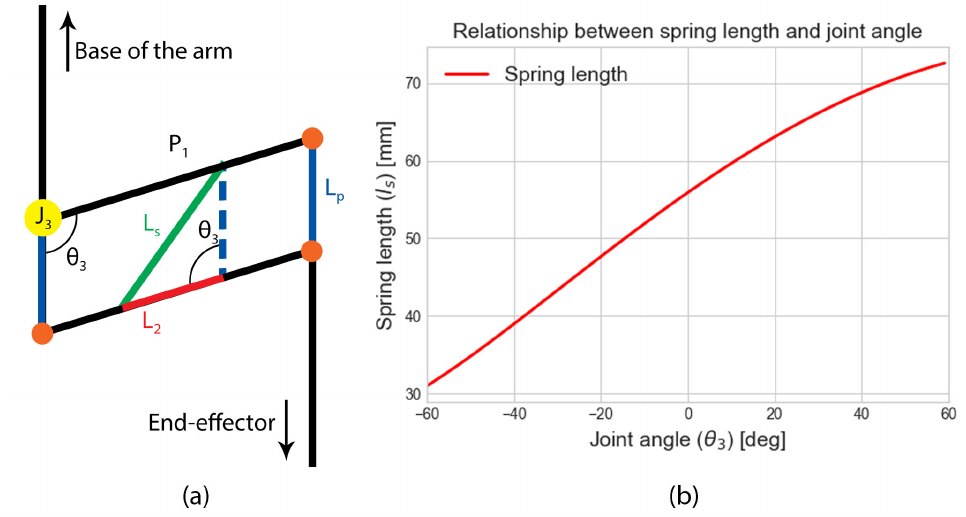
Figure 5. ( a ) Diagram to understand the spring length change in relation to joint angle; ( b ) relationship between spring length and joint angle θ 3